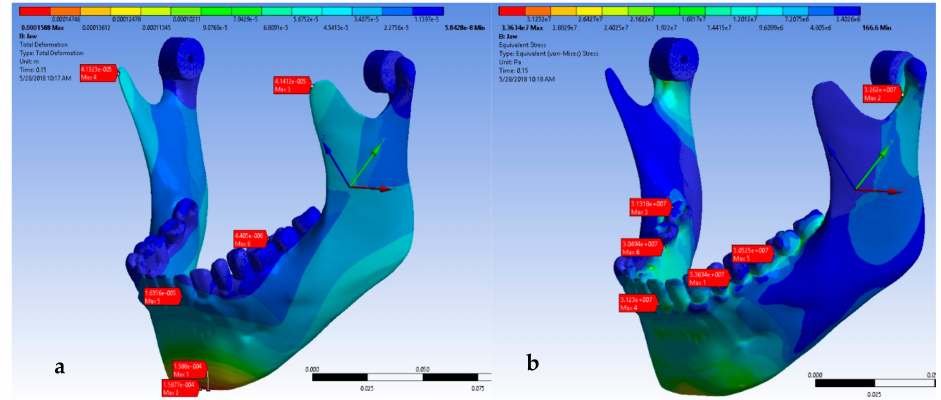
Figure 6. Total deformation ( a ) and equivalent stress distributions (the chin protuberance experienced the greatest deformation, nearly 0.16 mm) ( b ) on the mandible’s surface in the event of a collision with the anterior face of the chin region, with complete dentition. The premolar region experienced the highest stress, (approximately 34 MPa), and the condylar process region experienced a close value, of 33 Mpa.